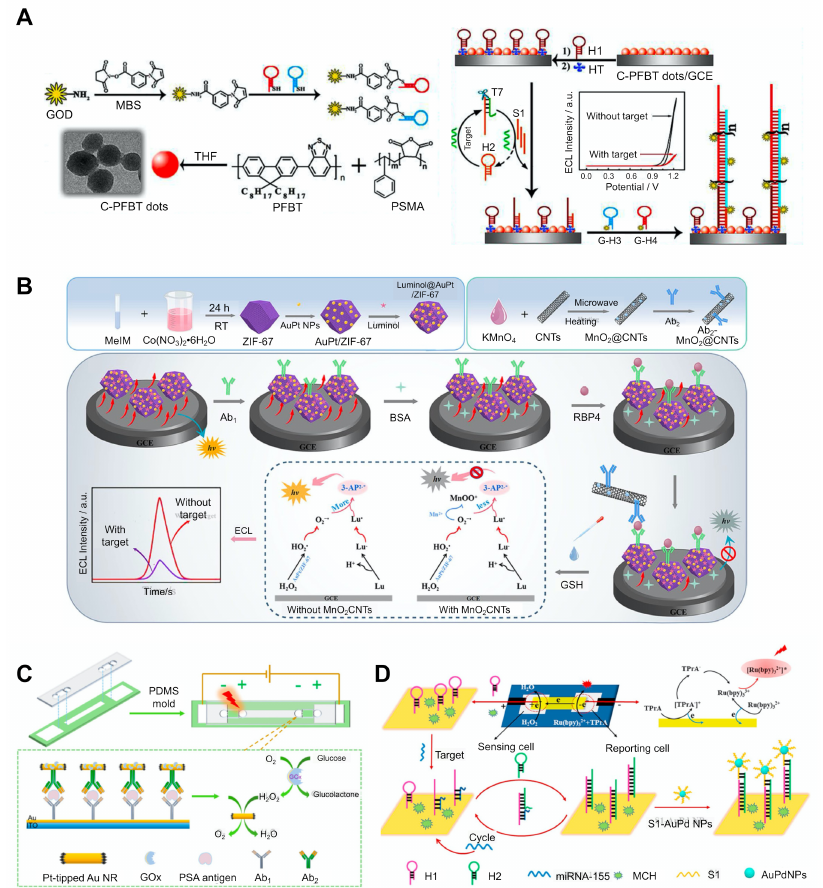
Figure 4. ECL-based sensing strategy and technology for the simple detection of